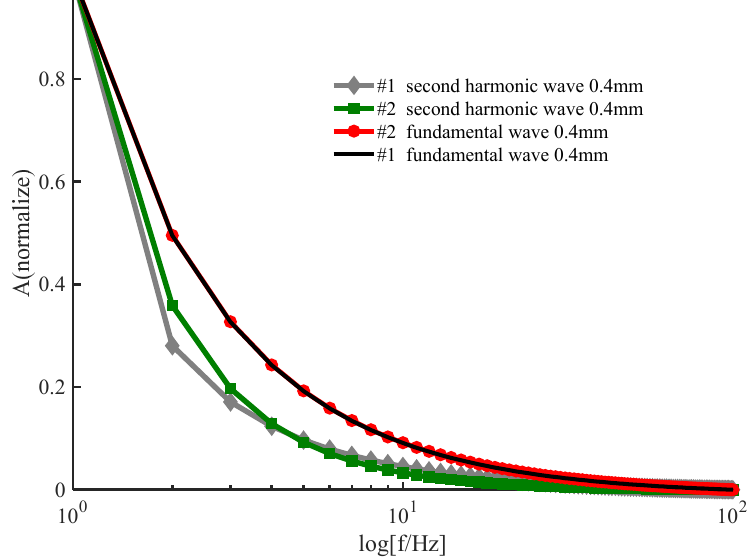
( a ) Fundamental frequency wave; ( b ) second harmonic; ( c ) third harmonic; ( d ) fourth harmonic.